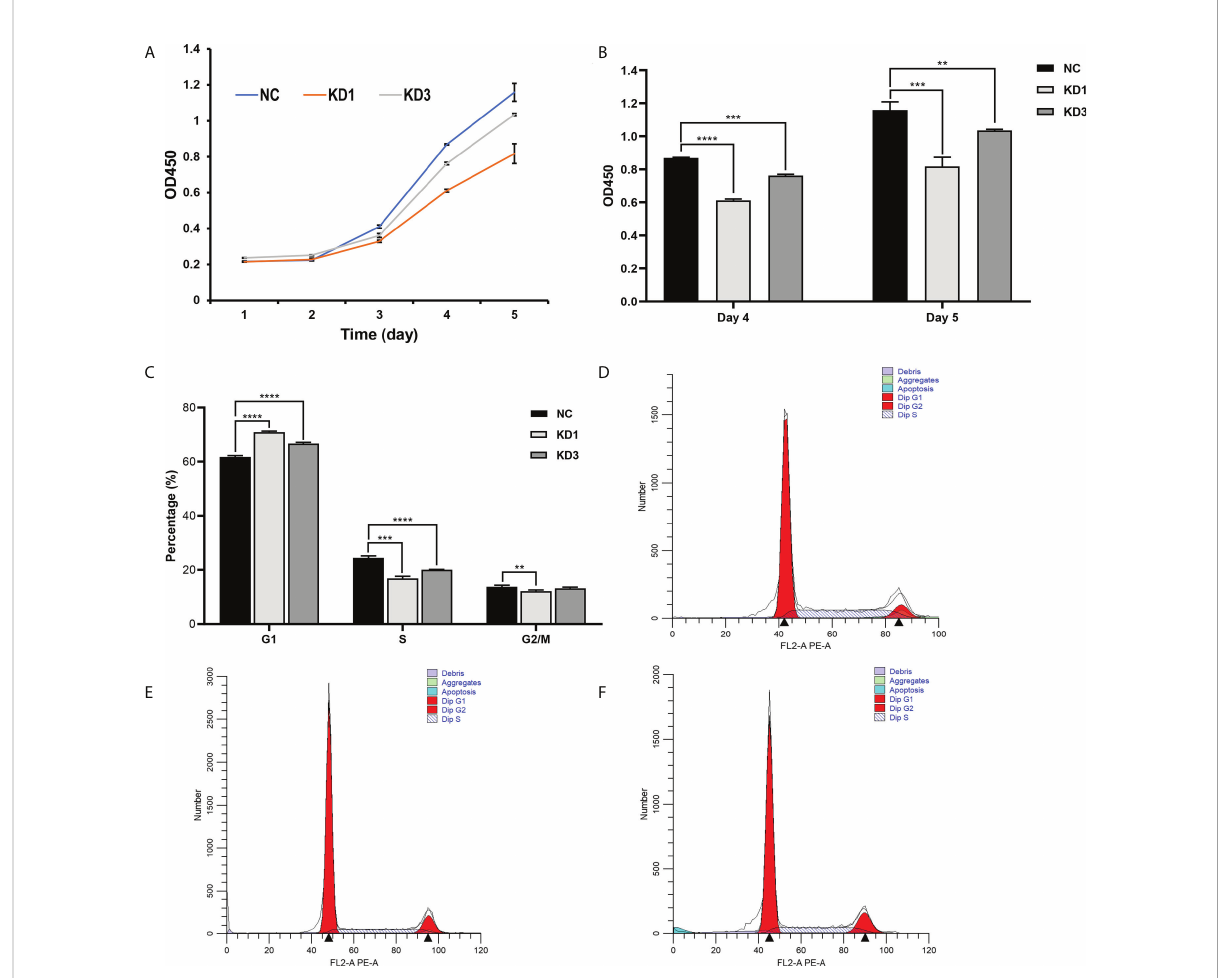
FIGURE 4 Effect of La RNAi on the viability and cell cycle of ovarian cancer A2780 cells. Cell viability kit was used to detect the effect of La RNAi on the viability of ovarian cancer A2780 cells (A) , and Cell Counting Kit-8 was used to detect the effect of La RNAi on the viability of ovarian cancer A2780 cells on the 4th and 5th days (B) . The effect of La RNAi on the cell cycle of ovarian cancer A2780 cells (C) in the NC group (D) , KD1 group (E) , and KD3 group (F) . All data were expressed as mean ± SD (** P < 0.05, *** P < 0.01, **** P <